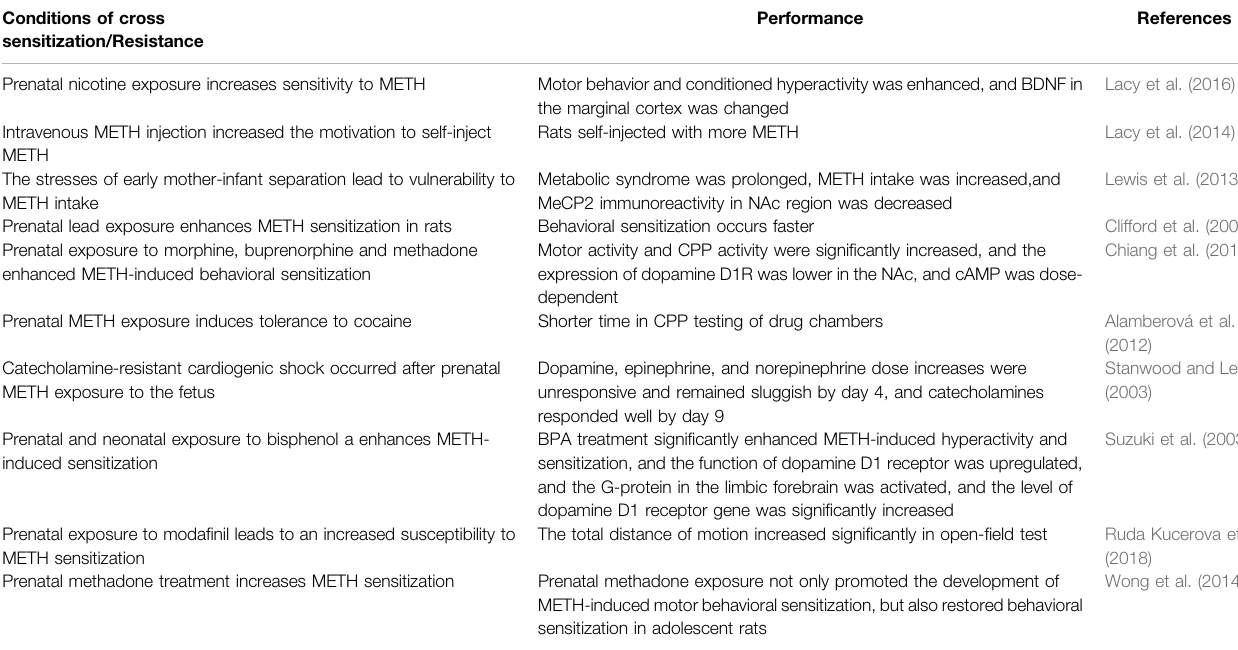
TABLE 1 | Sensitization associated with